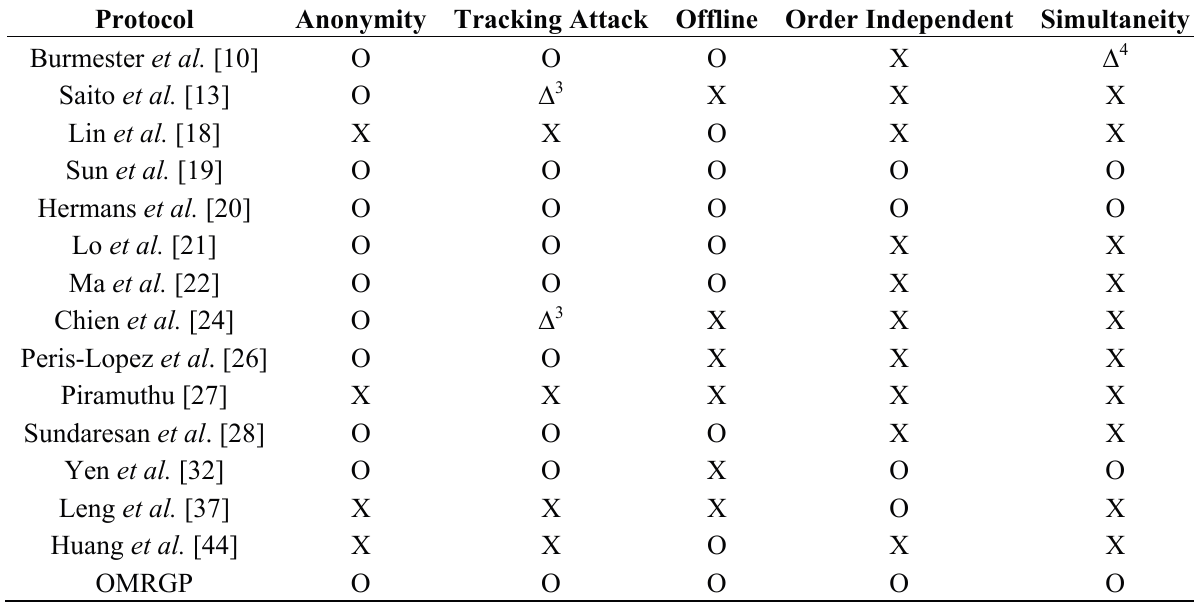
Table 3. Comparison of grouping proof